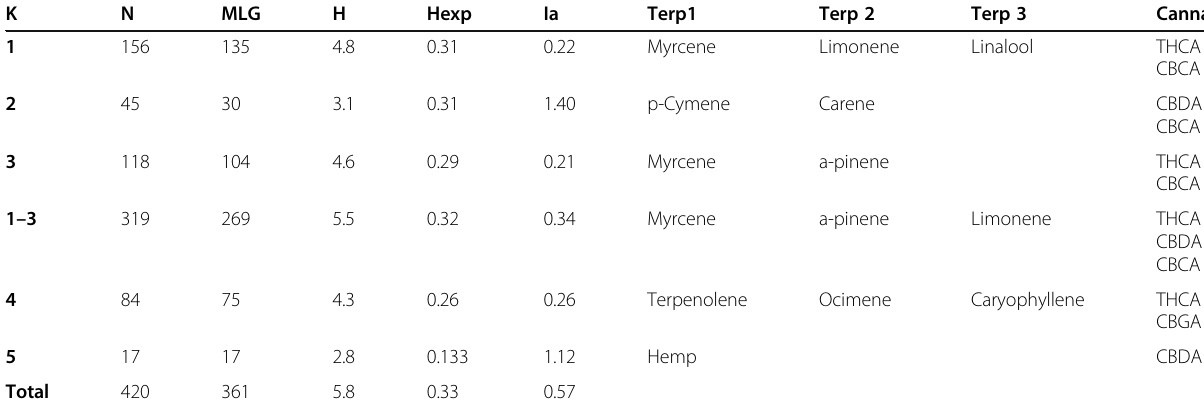
Table 1 Statistics, population genetic metrics and main chemotypes for inferred clusters K1-K5 K N